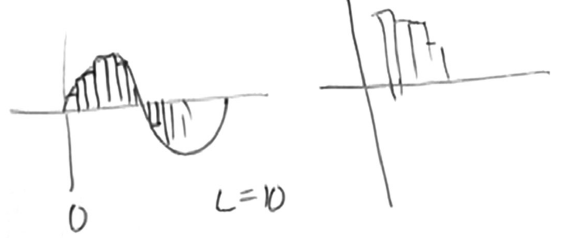
FIG. 6. Leanne ’ s attempt to make sense of the wave function as a histogram. She draws bars for different points of the wave function, but is not able to connect this to the expectation value of